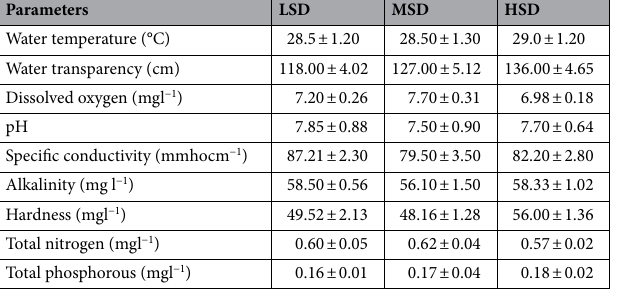
Table 4. Variations in cage water quality parameters in cages. Values are mean ± SE. No significant variation was observed in water quality parameters among different treatments ( P > 0.05). LSD low stocking density, MSD medium stocking density, HSD high stocking